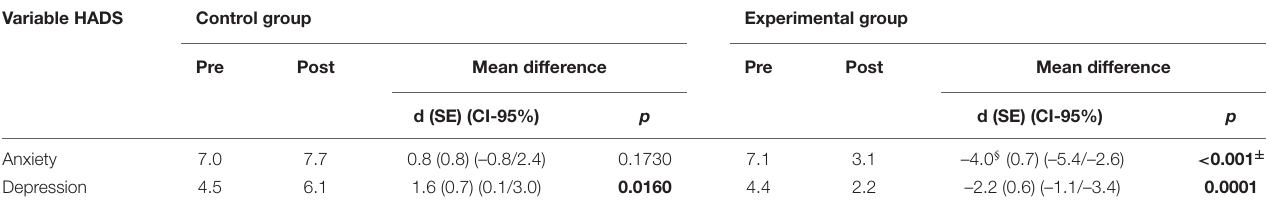
TABLE 3 | Comparison of the differences (posttreatment-baseline) between the CG and EG. Variable